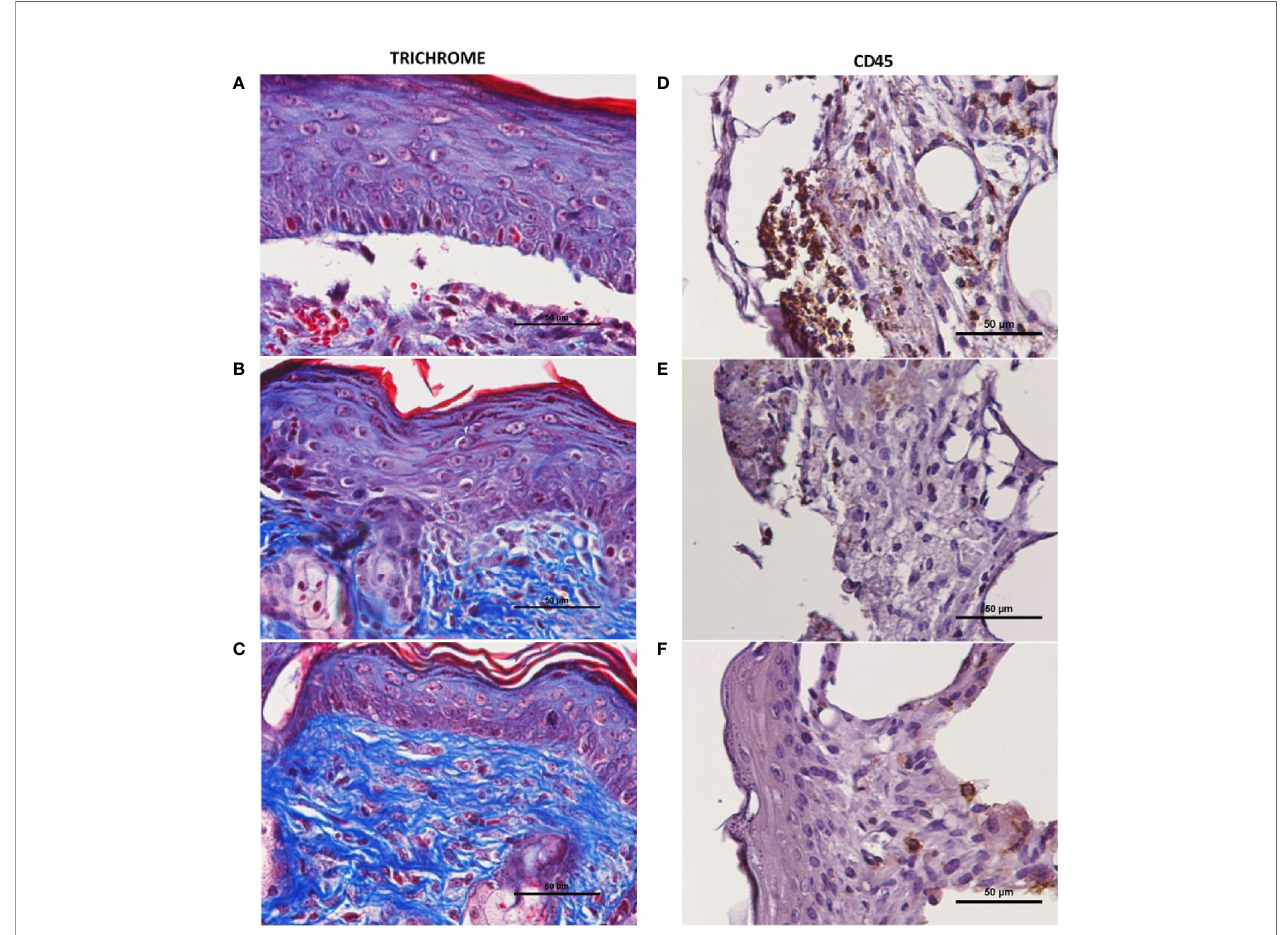
FIGURE 3 | Representative histology of fully healed diabetic wounds. There was an increase in collagen level (blue stained tissue in trichrome) after treatment with NS + CNP-miR146a (C) compared to those treated with PBS alone (A) . (A – C) 400× magni fi cation of trichrome-stained fully healed wounds. (D – F) 400×